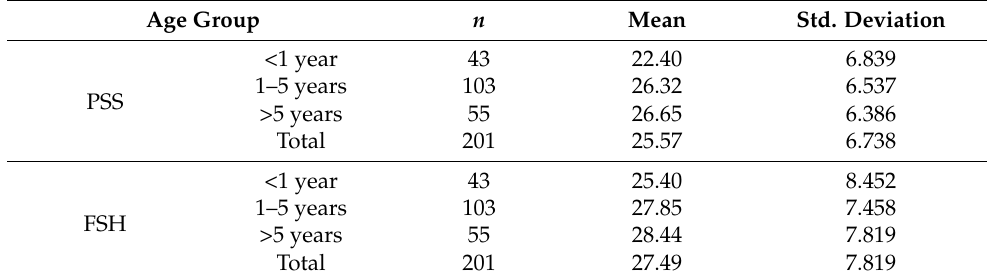
Table 6. Mean distribution of personal safety and sexual harassment regarding work experience.